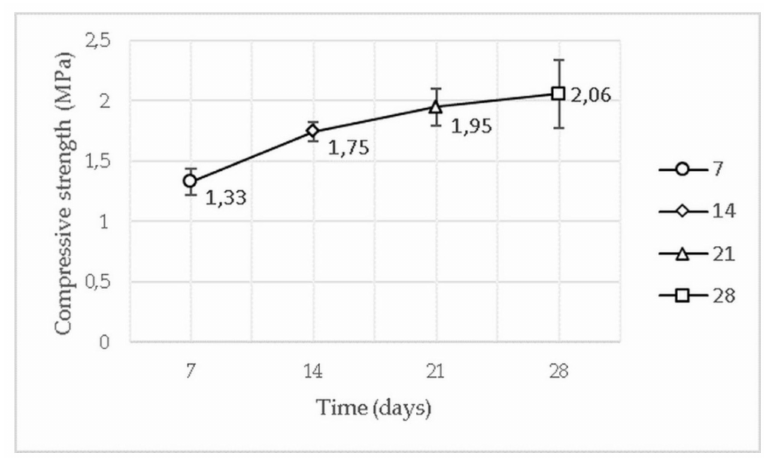
Figure 9. Evolution of the resistance gain of CEBs with 1:8 volume proportions [39].